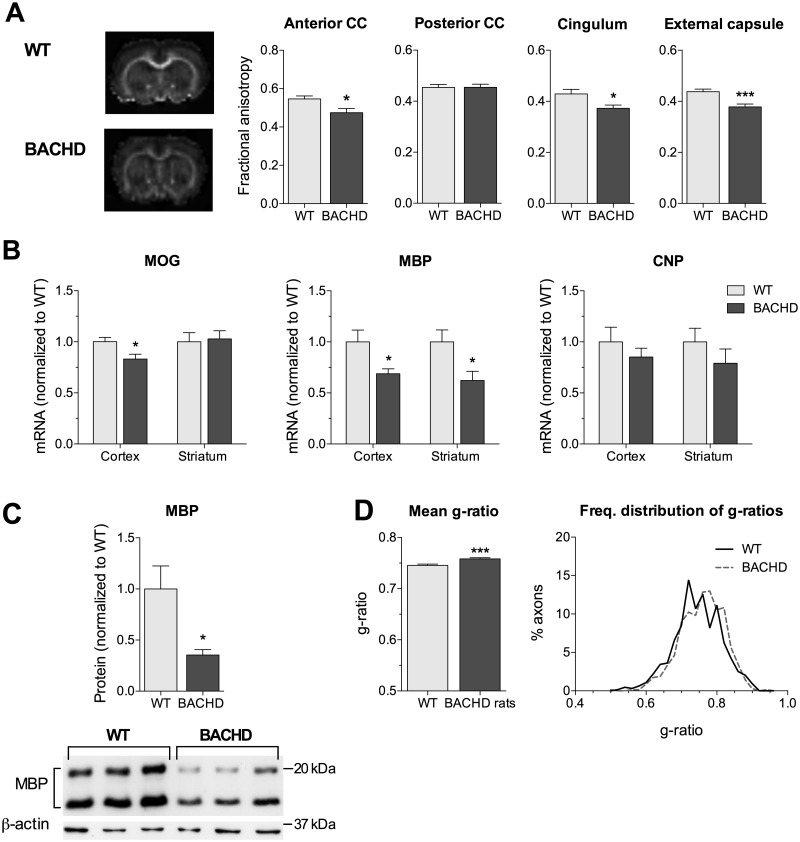
Abnormal white matter microstructure and reduced myelin-related gene expression in BACHD rats. (A) Reduced FA values in white matter-rich regions in BACHD rats compared with WT littermates at 12 months of age. cc, corpus callosum. (B) Lower levels of mRNA transcripts of myelin-related genes in the cortex (MOG and MBP) and the striatum (MBP) of BACHD rats at 12 weeks of age compared with WT littermates (n = 5–6/genotype; male). (C) Reduced cortical MBP protein levels in BACHD rats compared with WT littermates at 12 months of age (n = 3/genotype; male). (D) At 3.5 months of age, BACHD rats have higher average g-ratios, and the frequency distribution of the g-ratios of round healthy axons are shifted to the right, suggesting larger numbers of axons with thinner myelin sheaths. (B, C) All values were normalized to their respective WT littermate levels. * P < 0.05; *** P < 0.001.